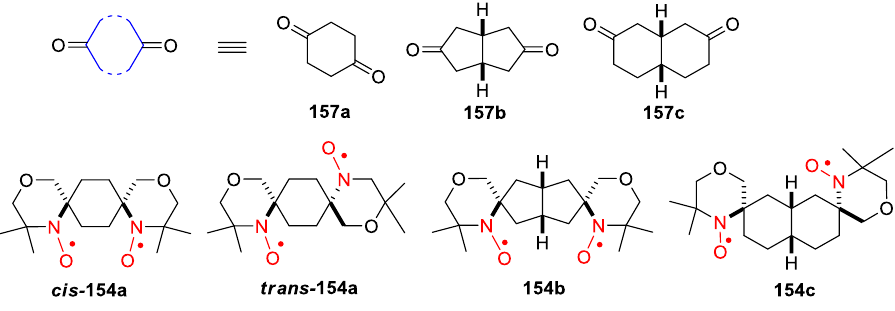
Figure 7. Top: parent diketones 157a–c ; bottom: synthesized diradicals 154a–c .